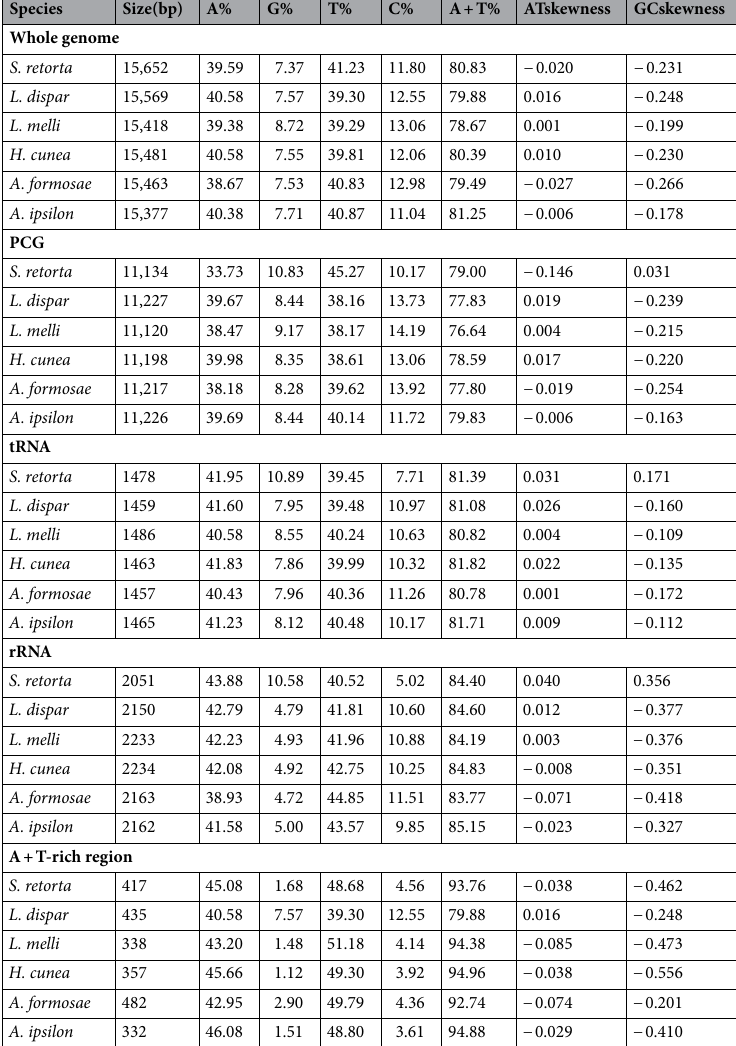
Table 2. The composition and skewness of mitogenomes of different Noctuoidea species